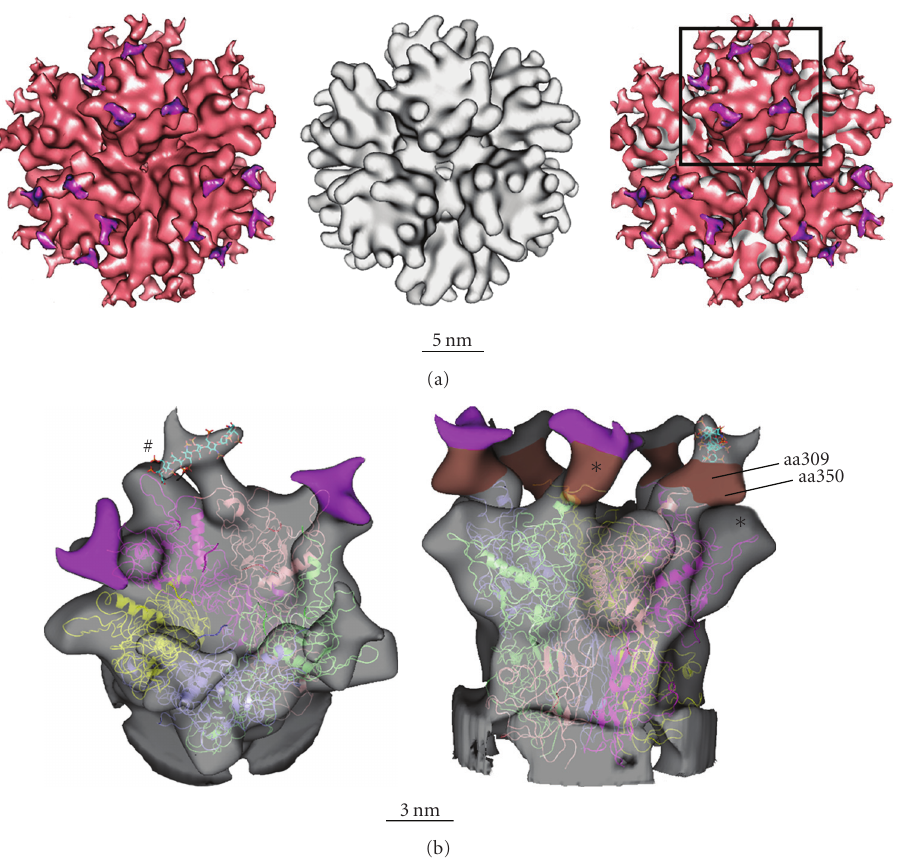
Figure 1: Cryo-EM reconstruction of Bs-Dd in complex to an HS oligosaccharide. (a) Bs-Dd was incubated with dp8 and the cryo-EM reconstruction of the complex (left panel; pink and purple) was compared to the Bs-Dd alone (middle panel; gray) by sur-imposing them (right panel). The purple density is attributed to the dp8 presence, the pink one to the Bs-Dd. (b) Fitting of both the HAd2 penton base atomic structure (PDB 1X9P) and of an octamer of N-acetyl glucosamine (PDB 1EHN) represented in blue into a Bs-Dd pentamer extradensity viewed in a top view (left) and side view (right) orientation. The symbol “#” highlights the less defined edge of the extra density suggesting therefore that the molecule occupying this part is more flexible compared to the opposite vertex. Asterisks denote the missing part of the RGD loop in the HAd2 X-ray structure (brown part) as well as the hyper variable loop (grey part) compared to the Bs-Dd